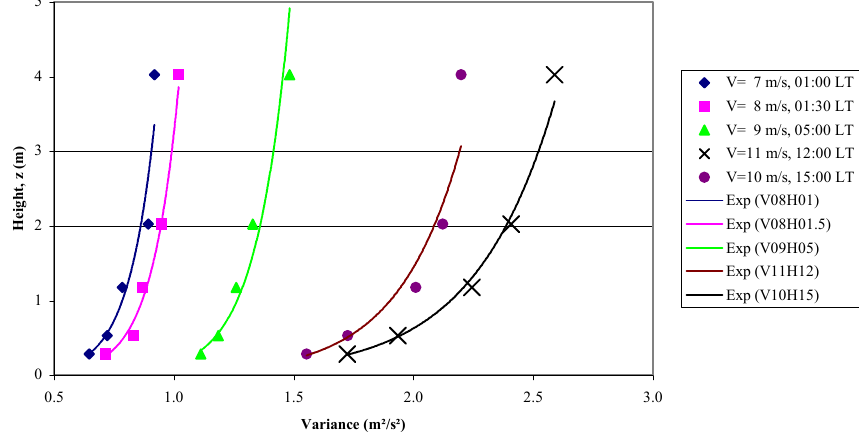
Figure 4: Variation of the horizontal wind variance with height (Plot CT, 25 July 1997) Fig. 4. Variation of the horizontal wind variance with height (Plot CT, 25 July 1997).